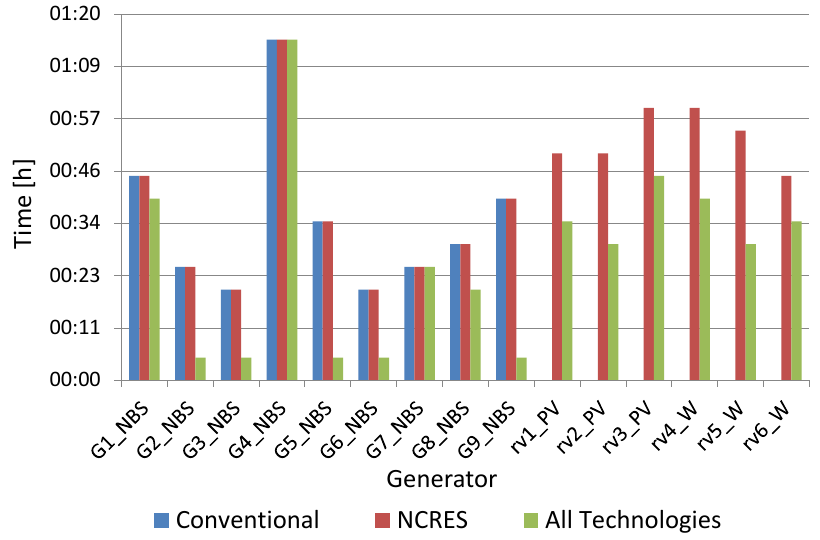
Figure 11. Generators start-up times.